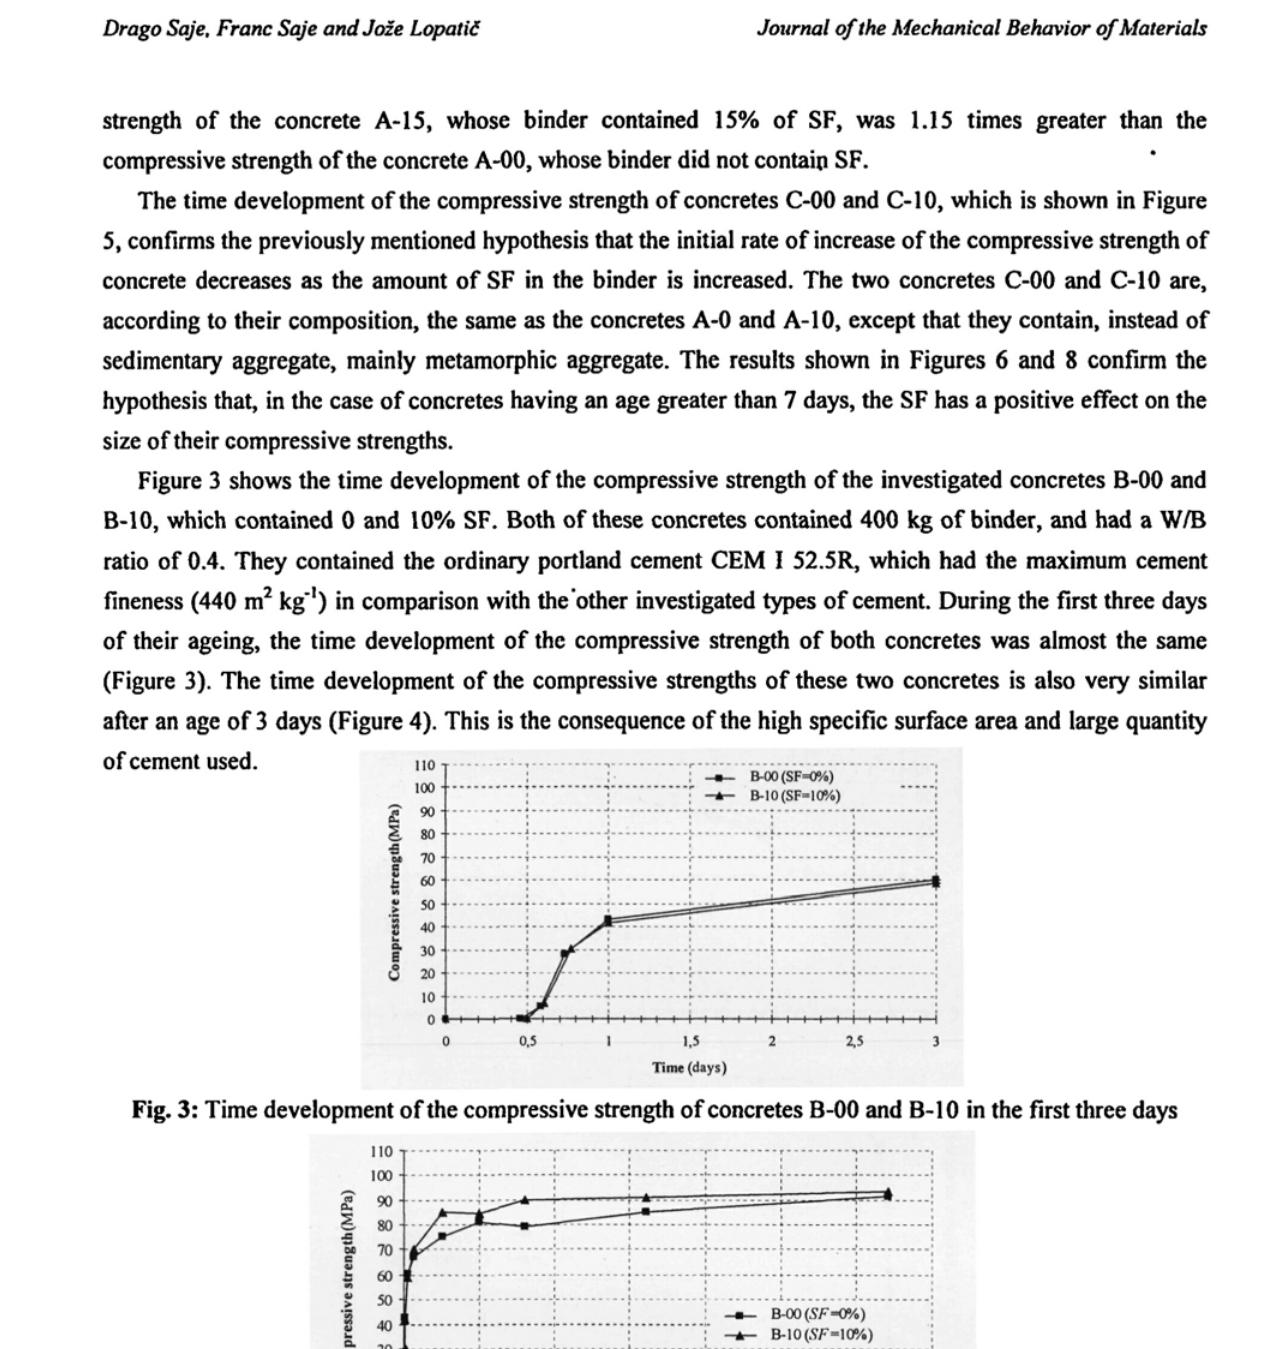
Fig. 3: Time development of the compressive strength of concretes B-00 and B-10 in the first three days